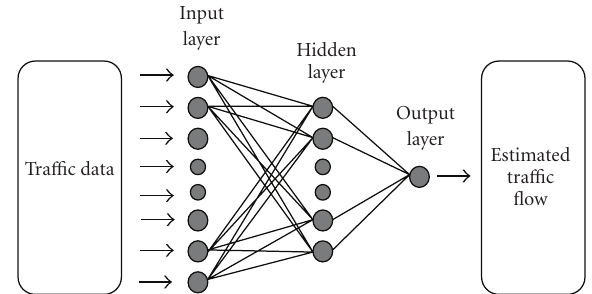
Figure 3: Employed hierarchical feed-forward ANN structure for tra ffi c